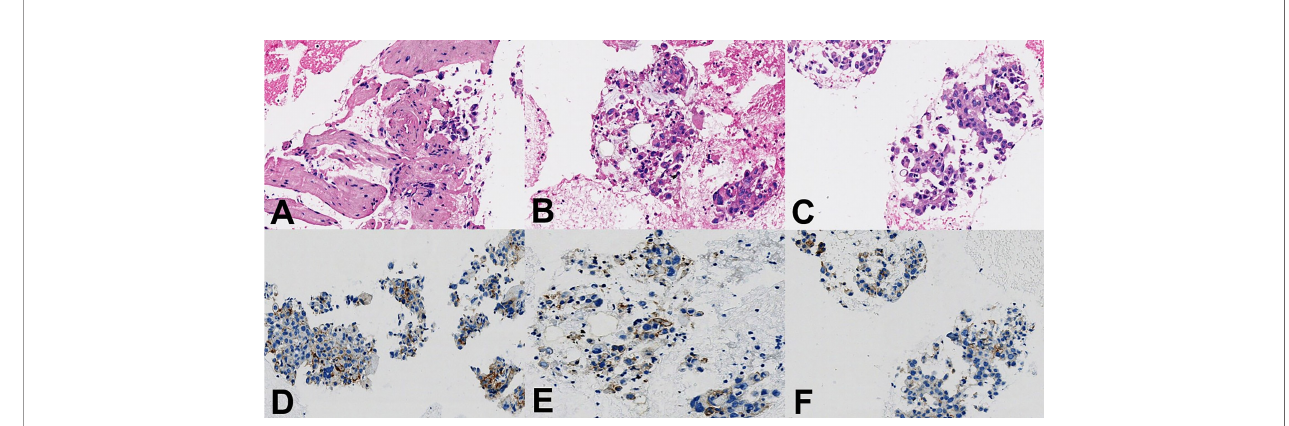
FIGURE 4 | Histopathological fi ndings. (A – C) Hematoxylin and eosin staining showed pleomorphic carcinoma with spindle and giant cells, ×400 magni fi cation. (D – F) Immunohistochemistry staining to assess PD-L1 expression showed the tumor proportion score was 40%, ×400 magni fi